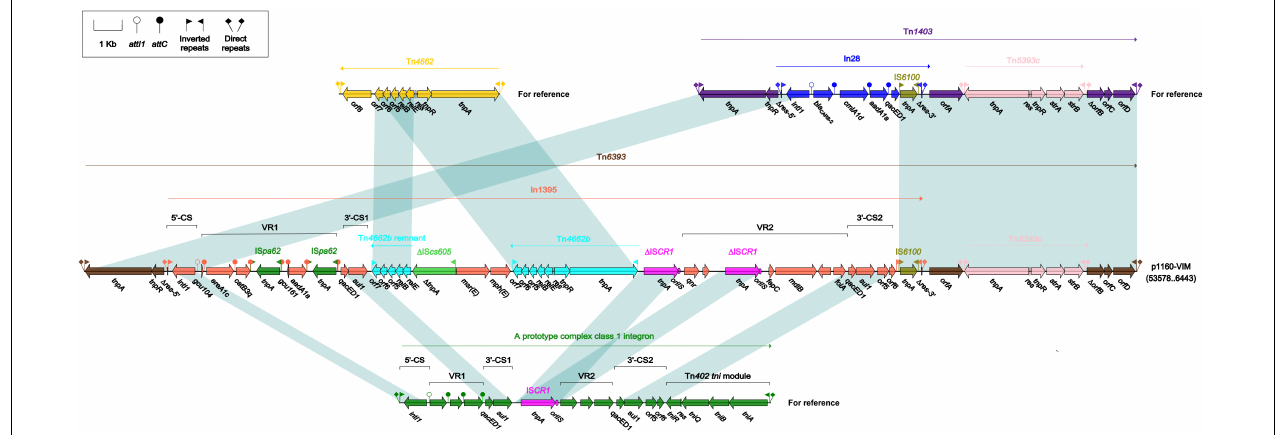
FIGURE 4 | Organization of Tn 6393 and comparison to related regions. Genes are denoted by arrows. Genes, mobile elements and other features are colored based on their functional classification. Shading denotes regions of homology (nucleotide identity > 95%). Numbers in brackets indicate nucleotide positions within corresponding plasmid sequences. Accession number of Tn 1403 for reference is AF313472.